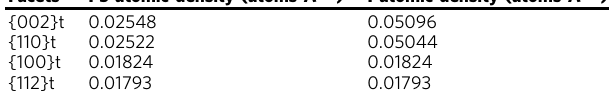
Table 1 Calculated atomic area density in different facets of typical MAPbI 3 crystals in tetragonal